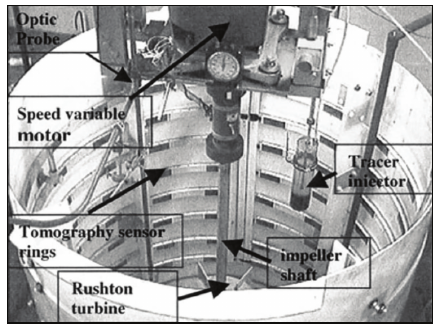
Figure5:The8-plane,16-electrodetomographysensorsystemfitted for ERT measurement by Wabo et al. (2005)